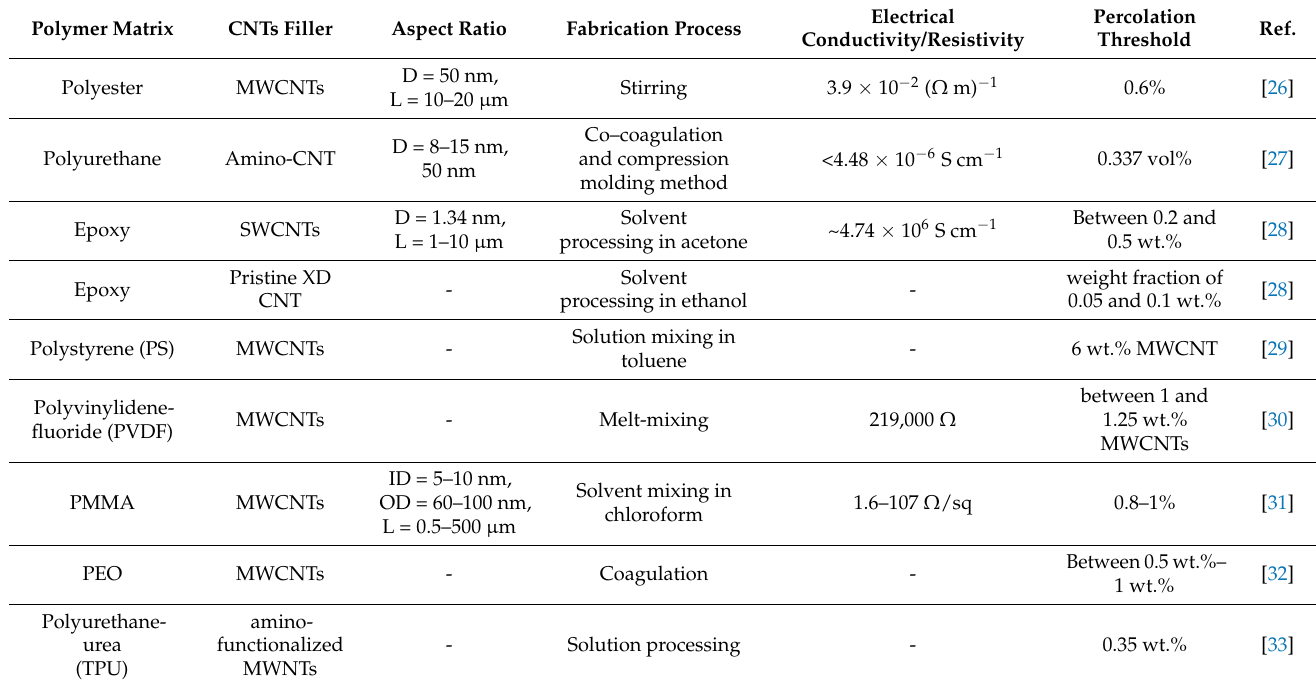
Table 1. Influence of processing conditions on the electrical